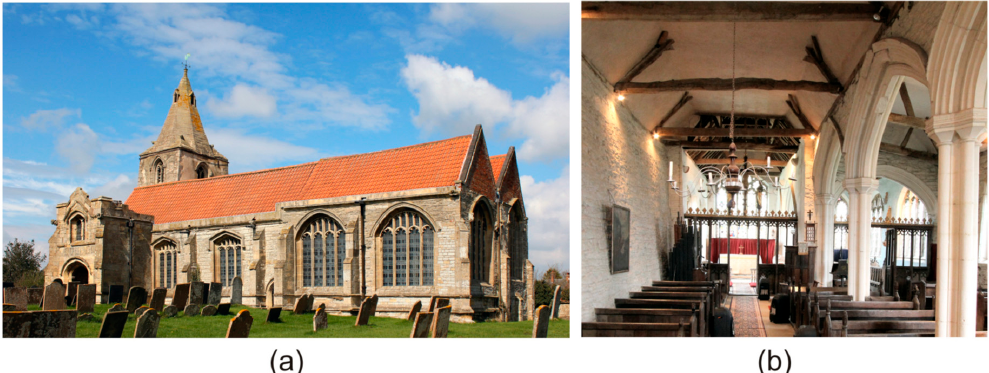
Figure 4. Holme-by-Newark church, Nottinghamshire, U.K. ( a ) the exterior; ( b ) interior of the nave showing the nave/chancel junction